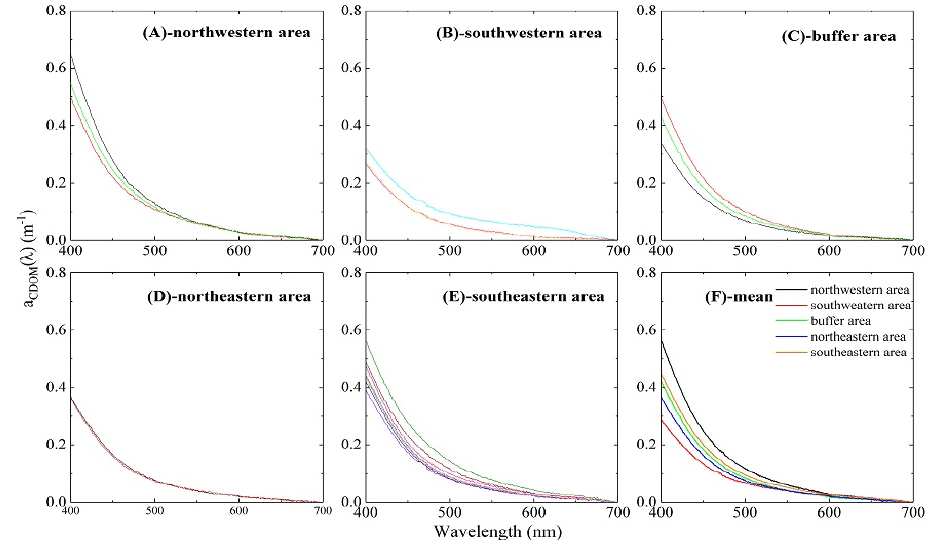
Figure 8. ( A – E ) CDOM absorption spectra in the different areas of the summer season in Lake Qiandaohu; and ( F ) the average CDOM absorption spectra for each area.